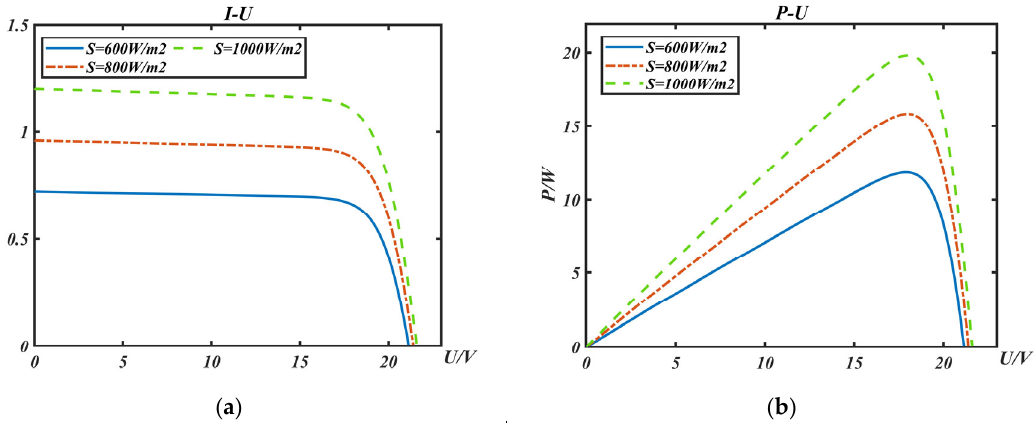
Figure 5. Effect of light intensity on the output characteristics of the photovoltaic cells. ( a ) I ‐ U. ( b ) P ‐ U. ( b )